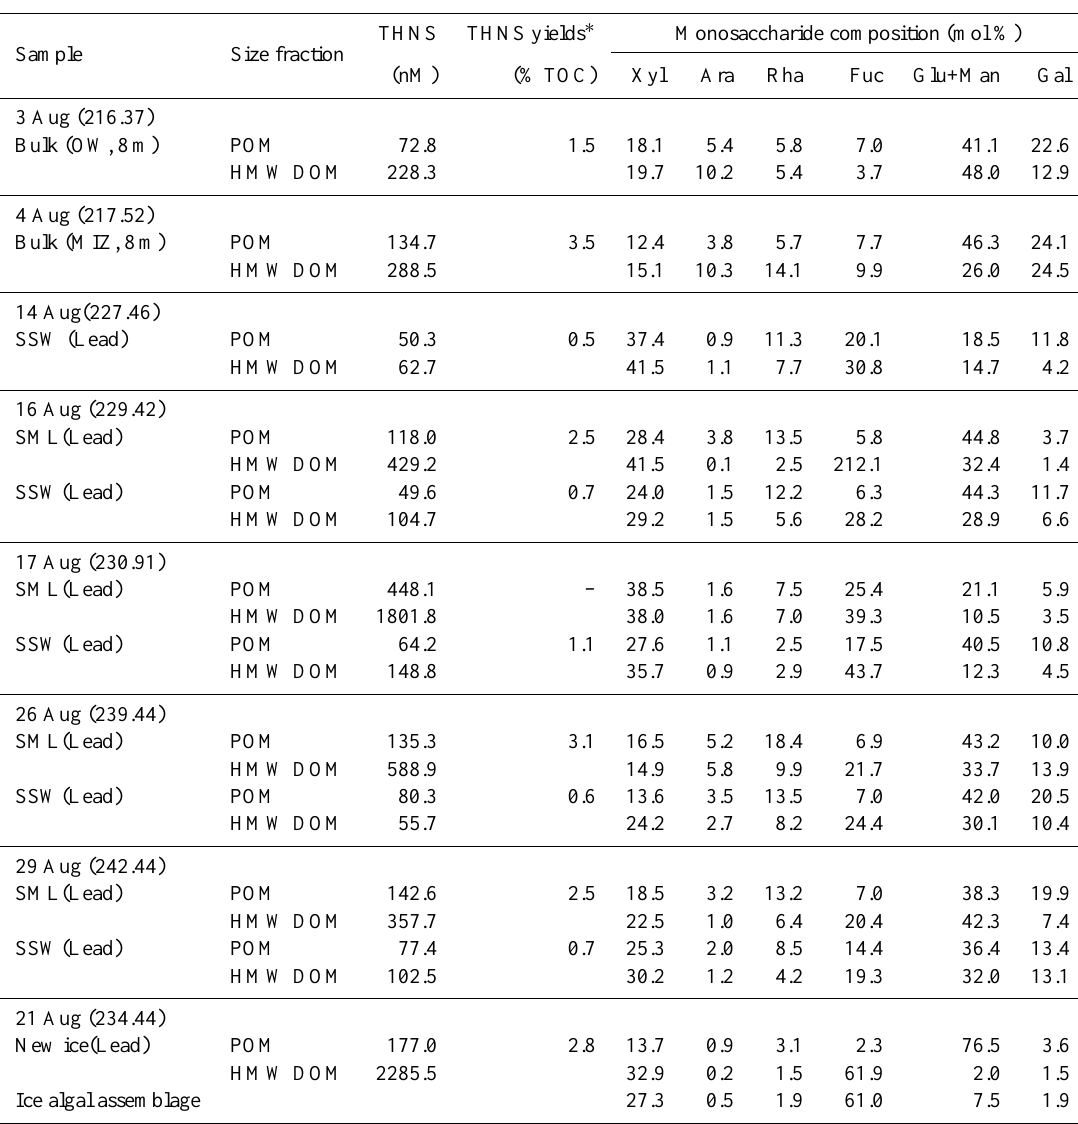
Table 5. Total hydrolysable neutral sugars (THNS) concentration (nM), NS yields (% TOC) and monosaccharide composition (mol%) in particulate (POM) and high molecular weight dissolved (HMW DOM) organic matter fractions of lead subsurface and surface microlayer sea- water. The monosaccharide abbreviations are Xyl (xylose), Ara (arabinose), Rha (rhamnose), Fuc (fucose), Glu+Man (glucose+mannose), Gal